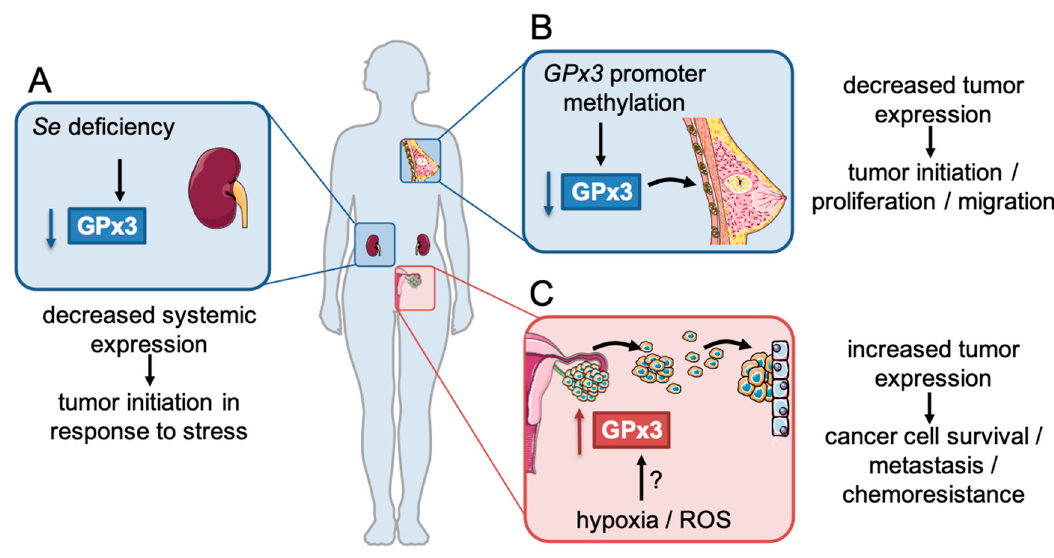
Figure 2. GPx3 has context-specific functions in cancer. ( A ) GPx3 expression can be altered at the systemic level in tumor patient plasma, likely as a consequence of Se deficiency. In animal models, decreased systemic GPx3 expression has been shown to be associated with tumor initiation in response to oxidative stress. ( B , C ) GPx3 expression is also altered within tumor tissues. ( B ) GPX3 promoter hypermethylation has been associated with decreased GPx3 expression in some tumor tissues, including breast cancer. Decreased GPx3 expression has been associated with tumor initiation, proliferation, and migration, as a consequence of increased oxidative stress and pro-tumorigenic redox signaling. ( C ) The dichotomous role of GPx3 is highlighted by observations that GPx3 expression is also increased in some tumor tissues, including ovarian cancer. Increased GPx3 expression is associated with stemness, increased cancer cell survival, chemoresistance and metastatic progression. While the mechanisms of increased GPx3 expression remain to be fully elucidated, it is possible that stress response pathways, including hypoxia and oxidative stress, may contribute to GPx3 expression in these tumors.